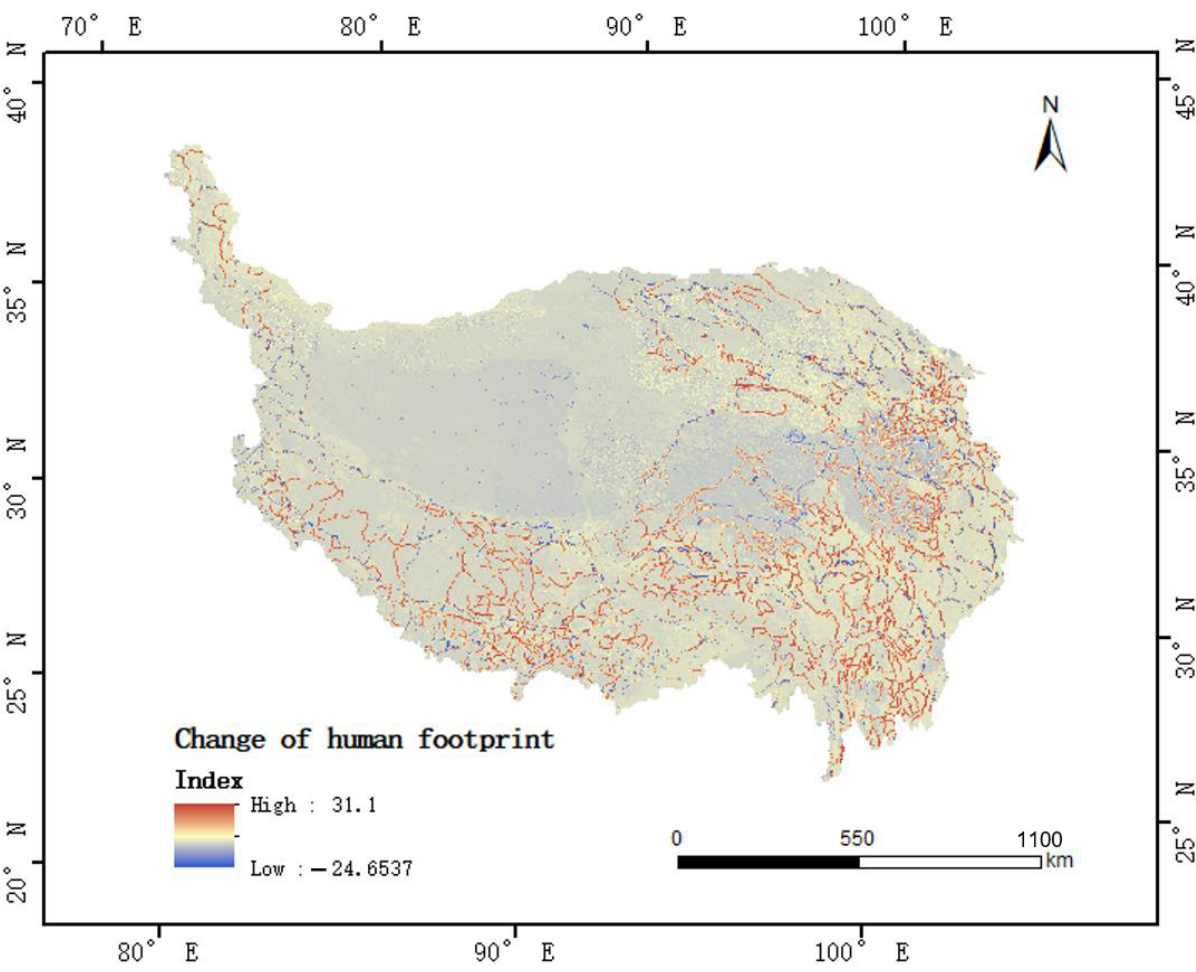
Figure 14. Changes in the intensity of human activities.